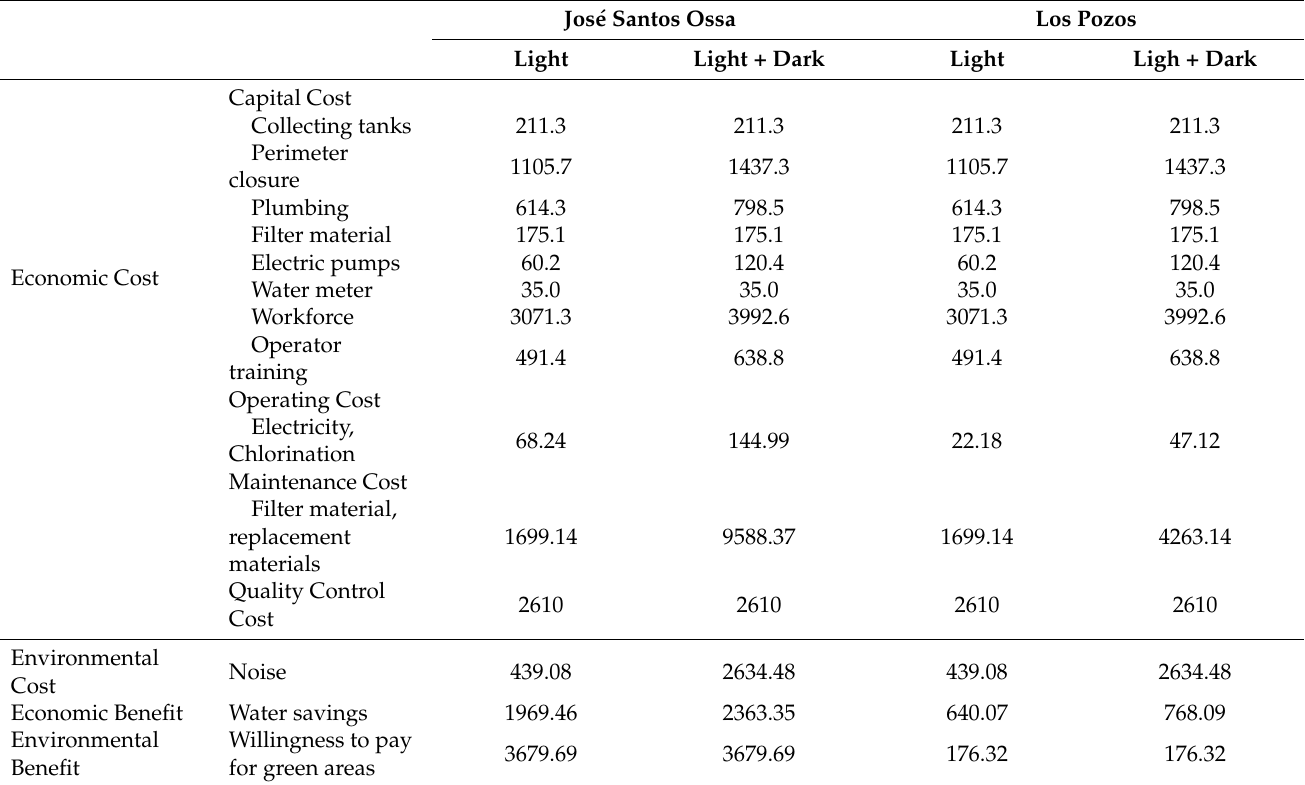
Table 4. Economic costs and benefits of the projects evaluated at 20 years